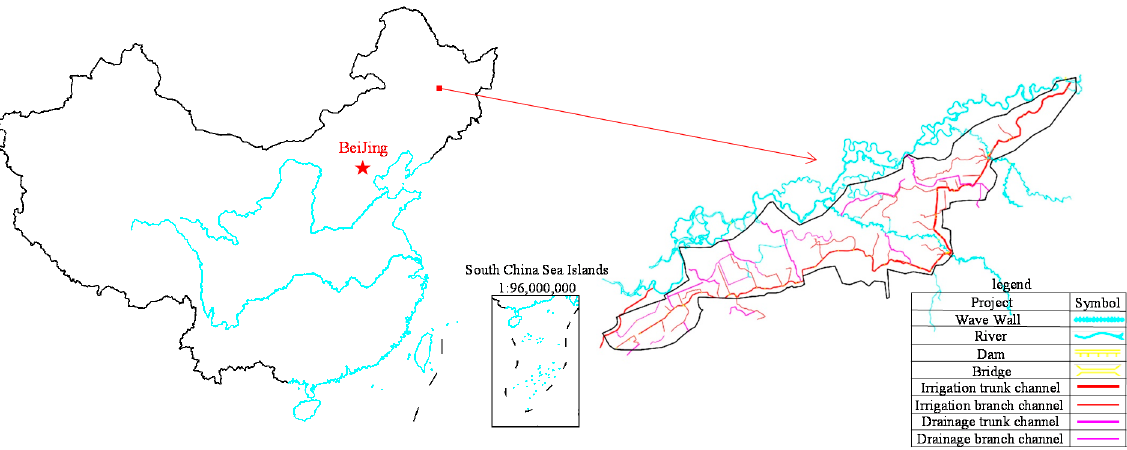
Figure 1. Diagram of the Heping Irrigation Area.